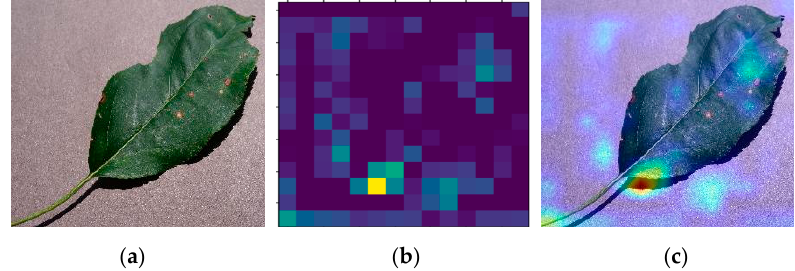
Figure 5. The details of three misclassified pictures: ( a ) the original picture, ( b ) the visualization of the final convolution layer, ( c ) the superposition of the heat map of the original picture.